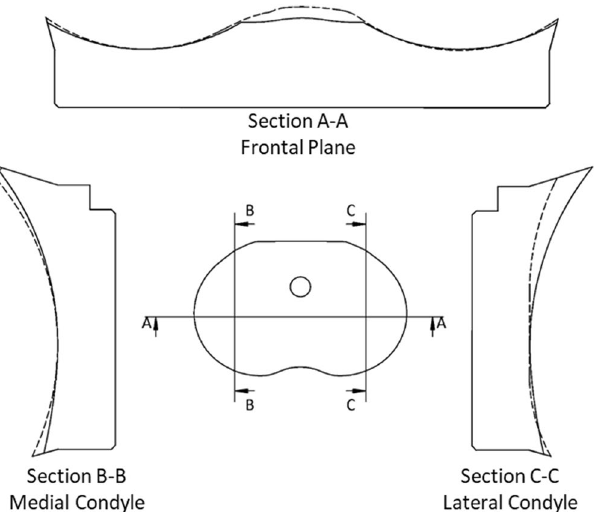
Figure 2. Comparison between the medial-pivot (dashed profiles) and ultra-congruent (solid lines) designs.